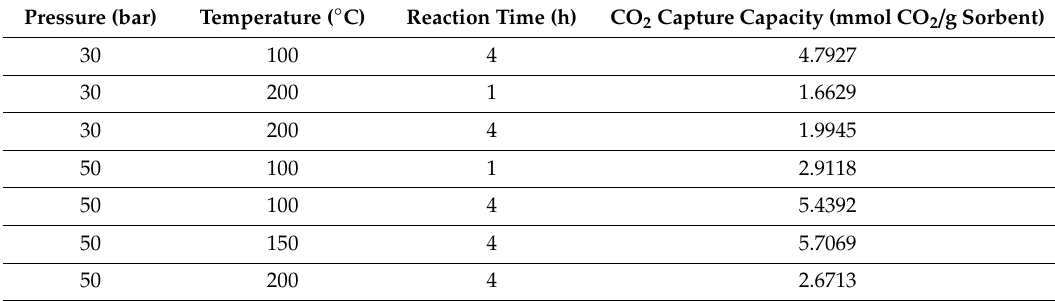
Table 3. CO 2 capture capacity of iron ore at di ff erent conditions of pressure, temperature, and reaction time in the high temperature–high pressure (HTHP)